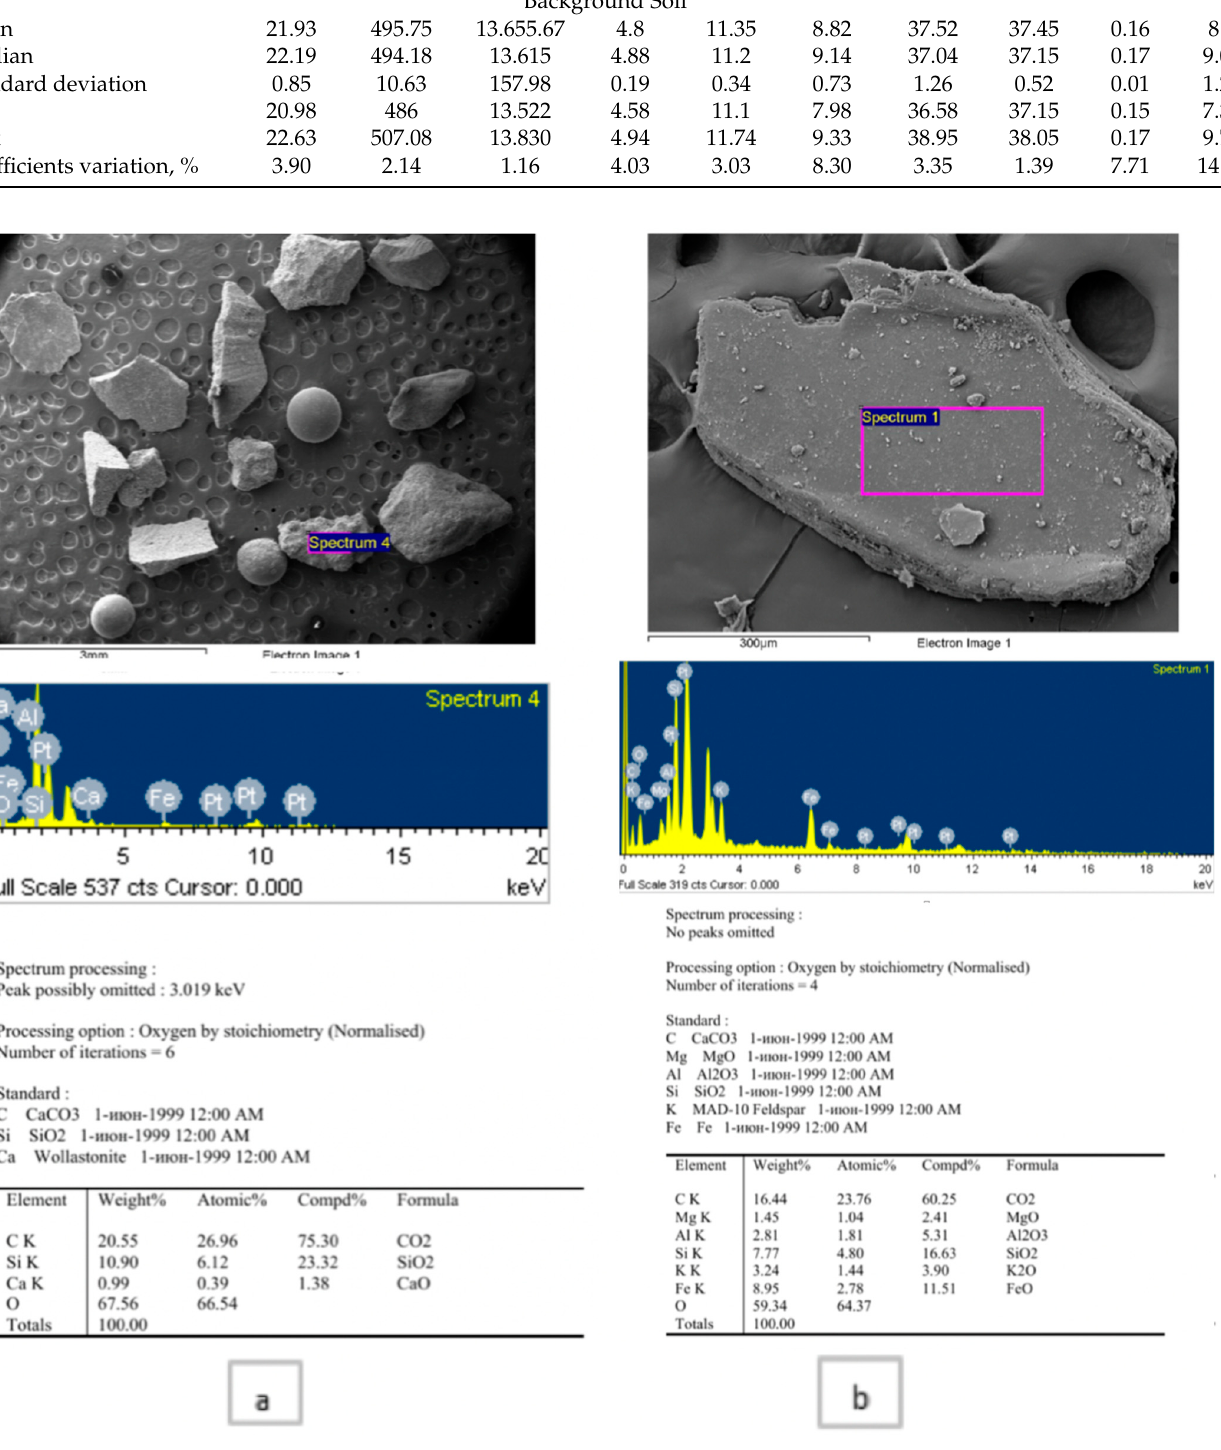
Figure 11. Morphology and energy dispersive spectra of road dust microparticles: ( a )—calcite grain; ( b )—biotite.